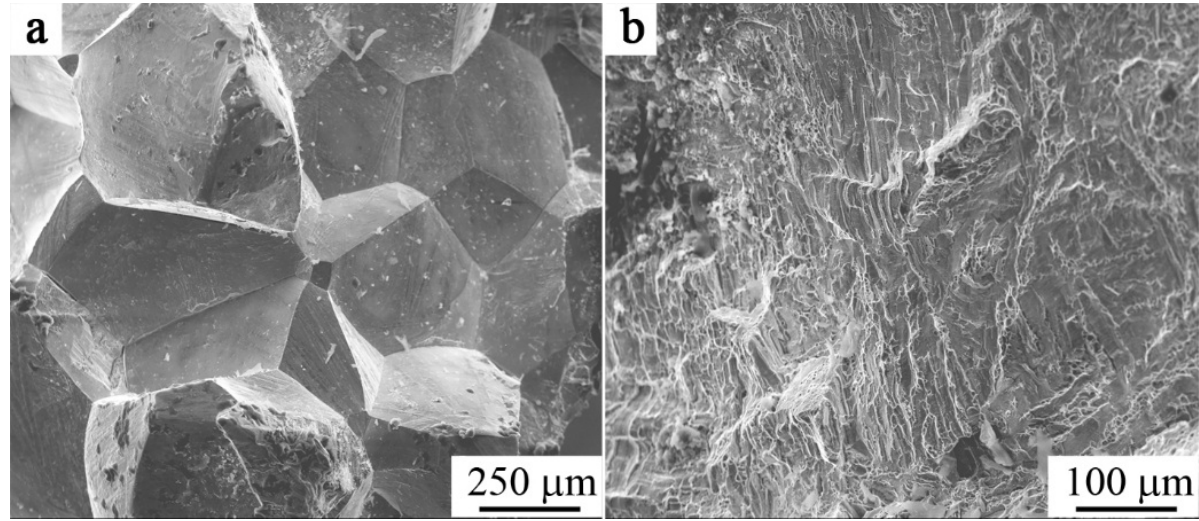
Figure 6. SEM images of fracture surface of the specimens of ( a ) Cu-14Al-3Ni and ( b ) Cu-10Al-3Ni [48].